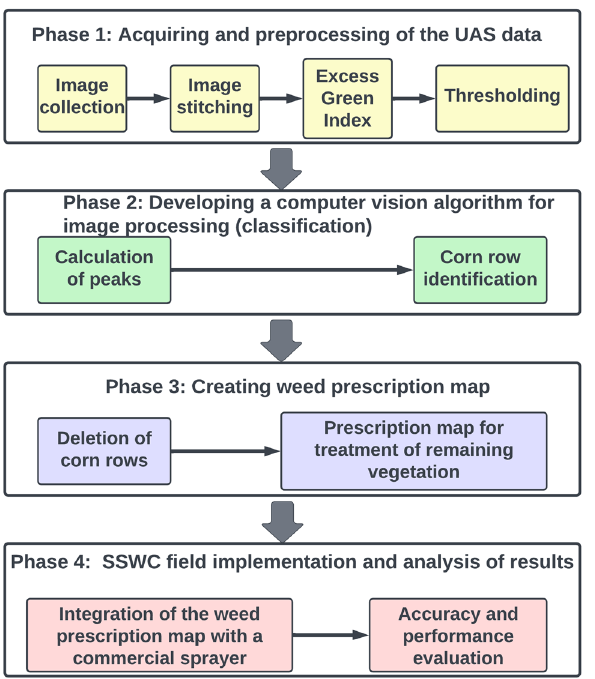
Figure 1. Workflow diagram followed to implement a site-specific weed control approach in a corn